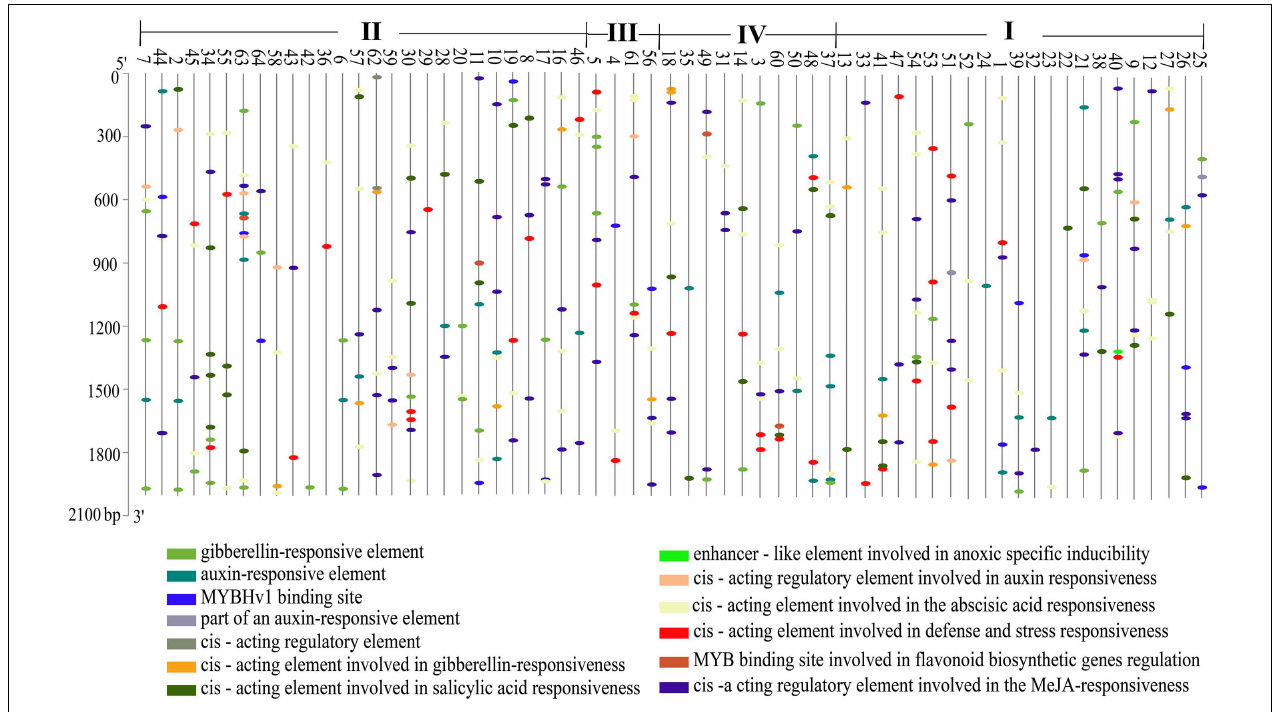
FIGURE 6 | Analysis of cis- acting elements of StMATE genes. Cis -acting elements that existed in the 2,000-bp upstream region of StMATE genes were analyzed. Numbers 1–64 represent genes StMATE1 – StMATE64 , respectively; I, II, III, and IV represent the four subfamilies. Boxes with different colors at the bottom represent the cis -acting